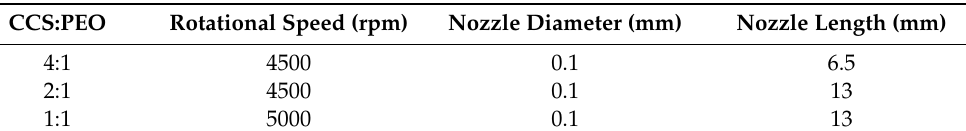
Table 1. Parameters setting of the three different ratios of CCS/PEO solutions.